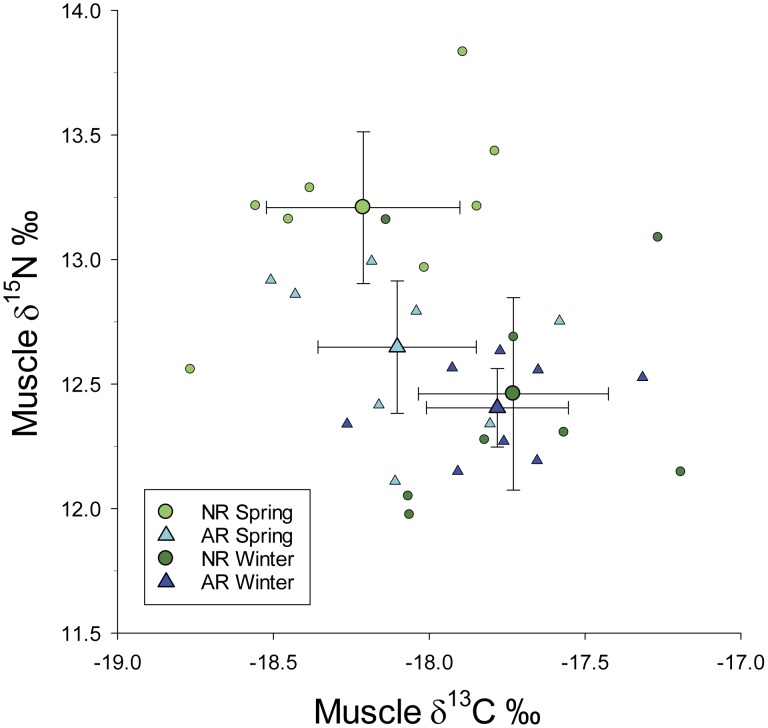
Bi-plot of lionfish muscle δ15N versus δ13C values.Plot of total length-corrected δ15N and δ13C values from lionfish white muscle samples collected at northern Gulf of Mexico natural (NR) and artificial (AR) reefs in spring 2013 and winter 2014. Mean values of δ15N and δ13C are depicted with 95% CI by the four combinations of season and habitat.